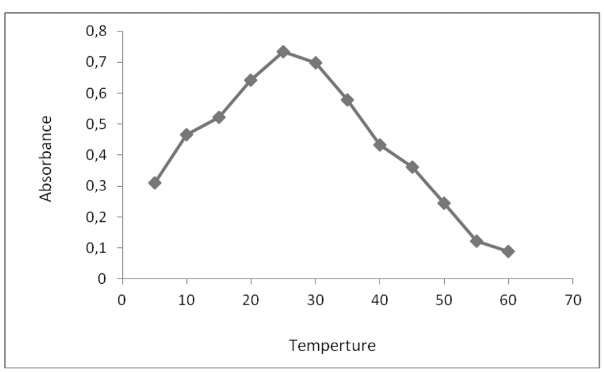
Figure 7 - Temperature influence on the absorbance of color